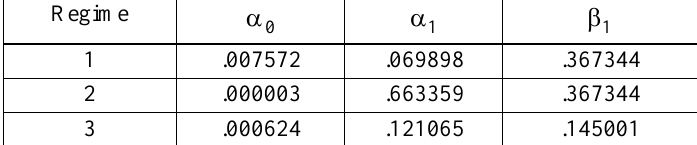
Table 4: Estimates of the coefficients of the 3-regime GARCH Model (authors’ calculations)